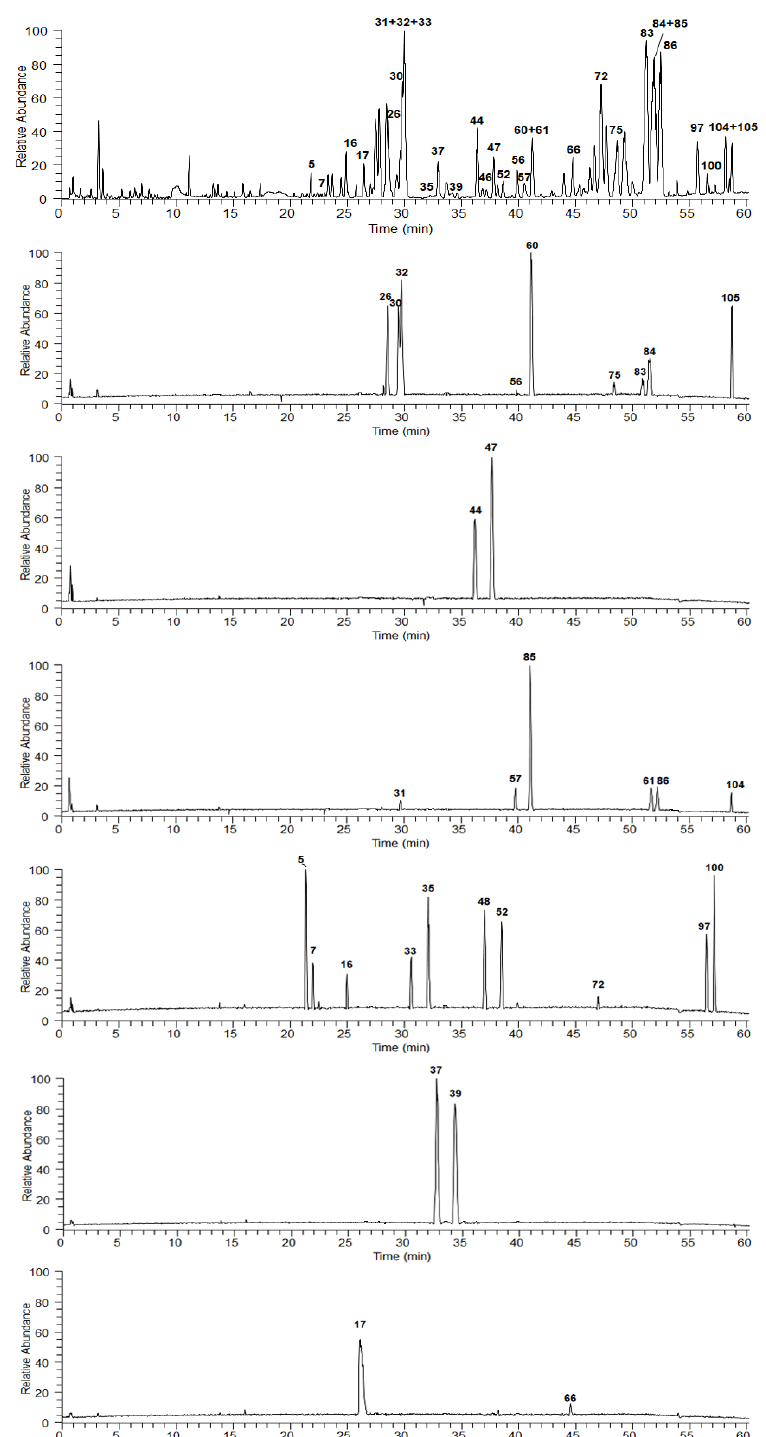
Figure 1. BPC for YS, and standard references 5 , 7 , 16 , 17 , 26 , 30 – 33 , 35 , 37 , 39 , 44 , 46 , 47 , 52 , 56 , 57 , 60 , 61 , 66 , 72 , 75 , 83 – 86 , 97 , 100 , 104 , 105 by UHPLC-ESI-Q-Exactive-Orbitrap MS / MS in positive ion mode.Column: Waters ACQUITY UPLC ® T 3 (2.1 × 100 mm, 1.8 μm). Mobile phase: H 2 O (A) and FA-MeOH-ACN (0.1:50:50, v / v / v ) (B). Gradient program: 0 – 15 min, 12 – 24% B; 15 – 30 min, 24 – 32% B; 30 – 42 min, 32 – 40% B; 42 – 47 min, 40 – 60% B; 47 – 65 min, 60 – 95% B. Flow rate: 0.3 mL/min. Column temperature: 30 °C. Injection volume: 3 µL. ESI-Q-Exactive-Orbitrap MS mode: positive ion mode.